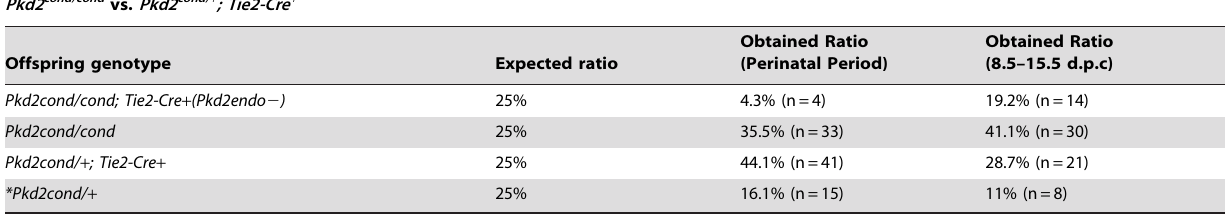
Table 2. Deletion of Pkd2 in endothelial